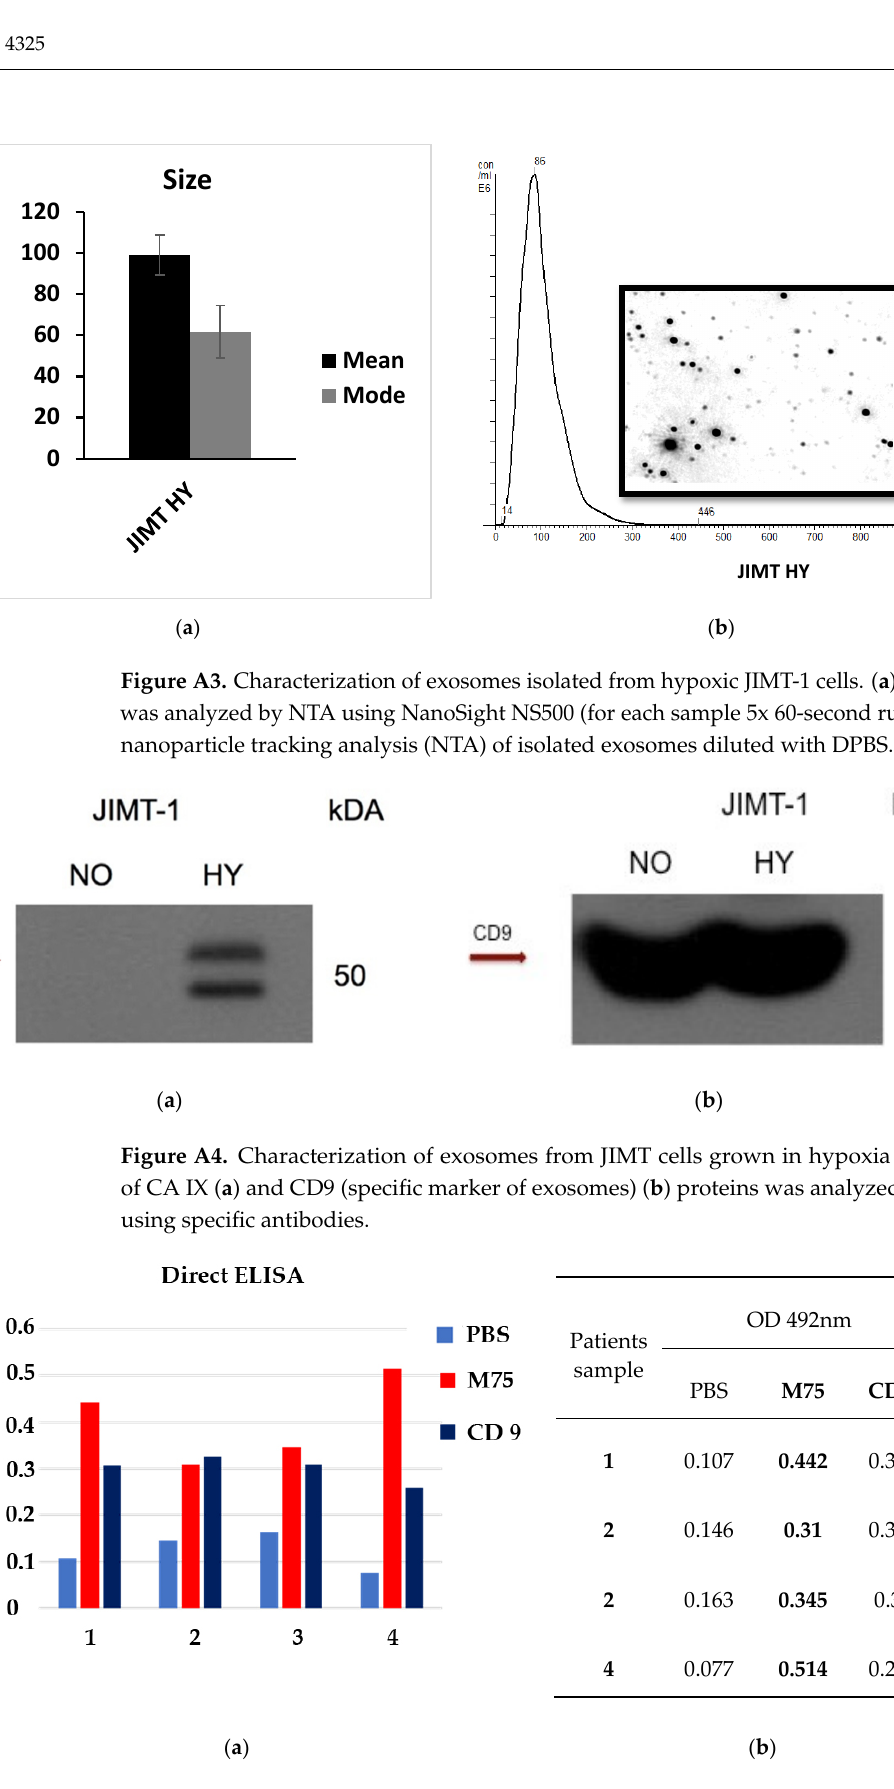
Figure A5. Characterization of exosomes isolated from the plasma of four patients. ( a ) Expression of CA IX and CD9 (specific marker of exosomes) analyzed by direct ELISA; ( b ) OD values at 492 nm.